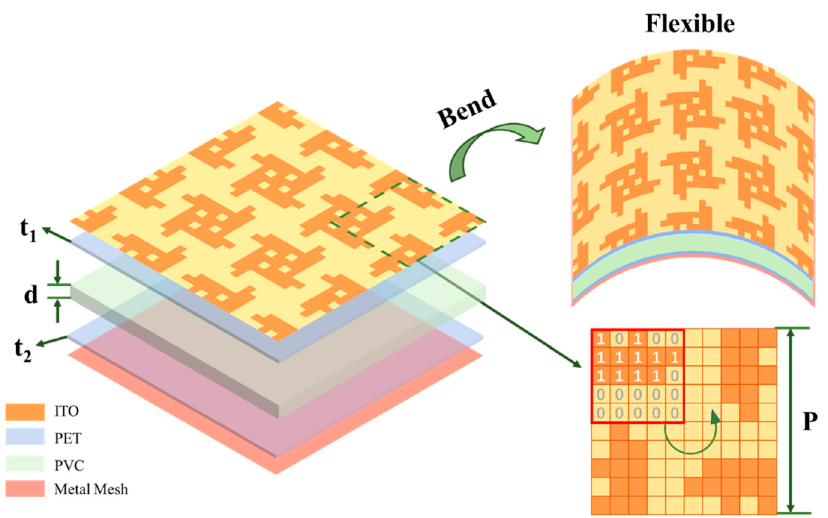
Figure 2. ( left ) Exploded view and ( upper right ) bending schematics of FTBMA (4 × 4 structure). ( lower right ) Top view of its unit cell configuration.